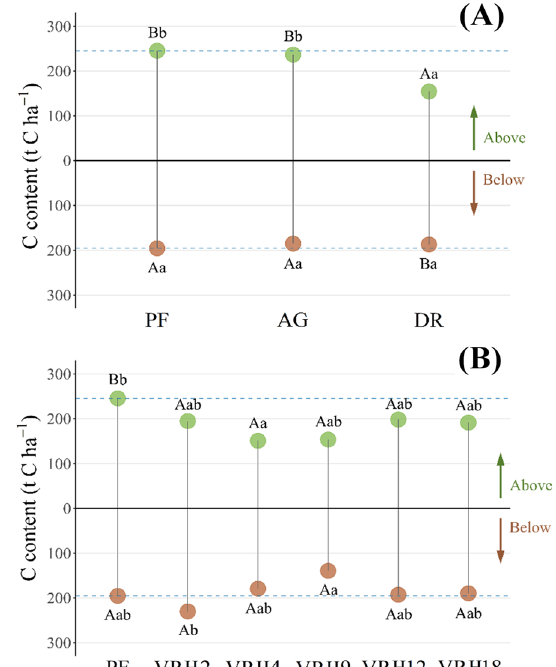
Fig. 3 Comparisons of carbon content (t C ha − 1 ) using simple ANOVAs: A primary unmanaged forests (PF) and different retention types in harvested stands (AG: aggregated retention, DR: dispersed retention), and B primary unmanaged forests (PF) and stands under variable retention harvesting (VRH) at different years‑after‑harvesting (2 to 18 years). Different letters showed significant differences between reservoirs above‑ (green) and below‑ground (brown) (capital letters), or among treatments (lowercase letters). Dashed blue lines showed PF average carbon contents. Statistic values are presented in Additional file 1: Appendix